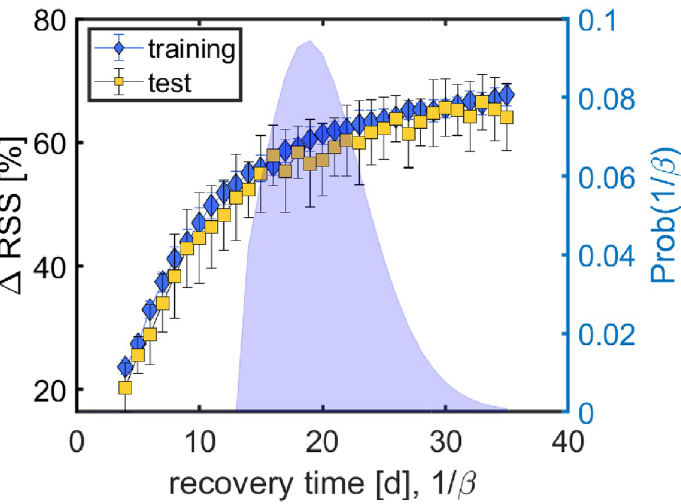
Fig 2. Results for the cross-validated hyperparameter search. For different recovery times, 1/ β , we show the percent change in RSS, Δ RSS , between null and augmented model for training (blue) and test (yellow) data. For recovery times of more than 20d, the augmented model explains more than 60% of the regional variations in both test and training data. The probability distribution for 1/ β [39] is shown on the axis to the right-hand side.